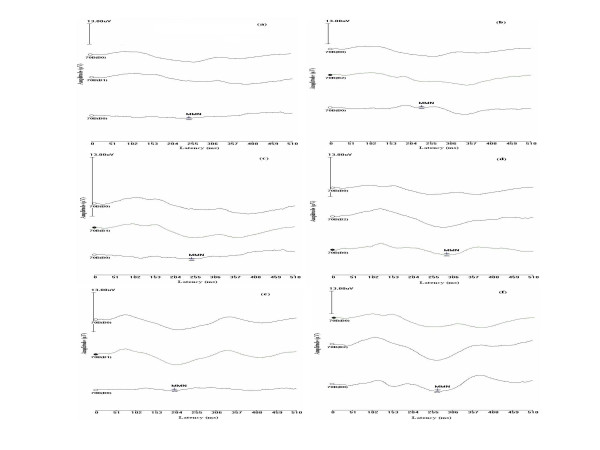
(a to f). The figure shows grand mean MMNs of control group. Figure 2a to 2f represents the waves elicited for /tΣa/-/dZa/, /tΣa/-/sa/, /da/-/δ8a/, /da/-/das/, tonal frequency and tonal duration contrasts respectively. Each sub-figure has a standard, a deviant and a difference wave respectively. The waves are scaled to 13 μV and the MMN is marked on the difference wave.